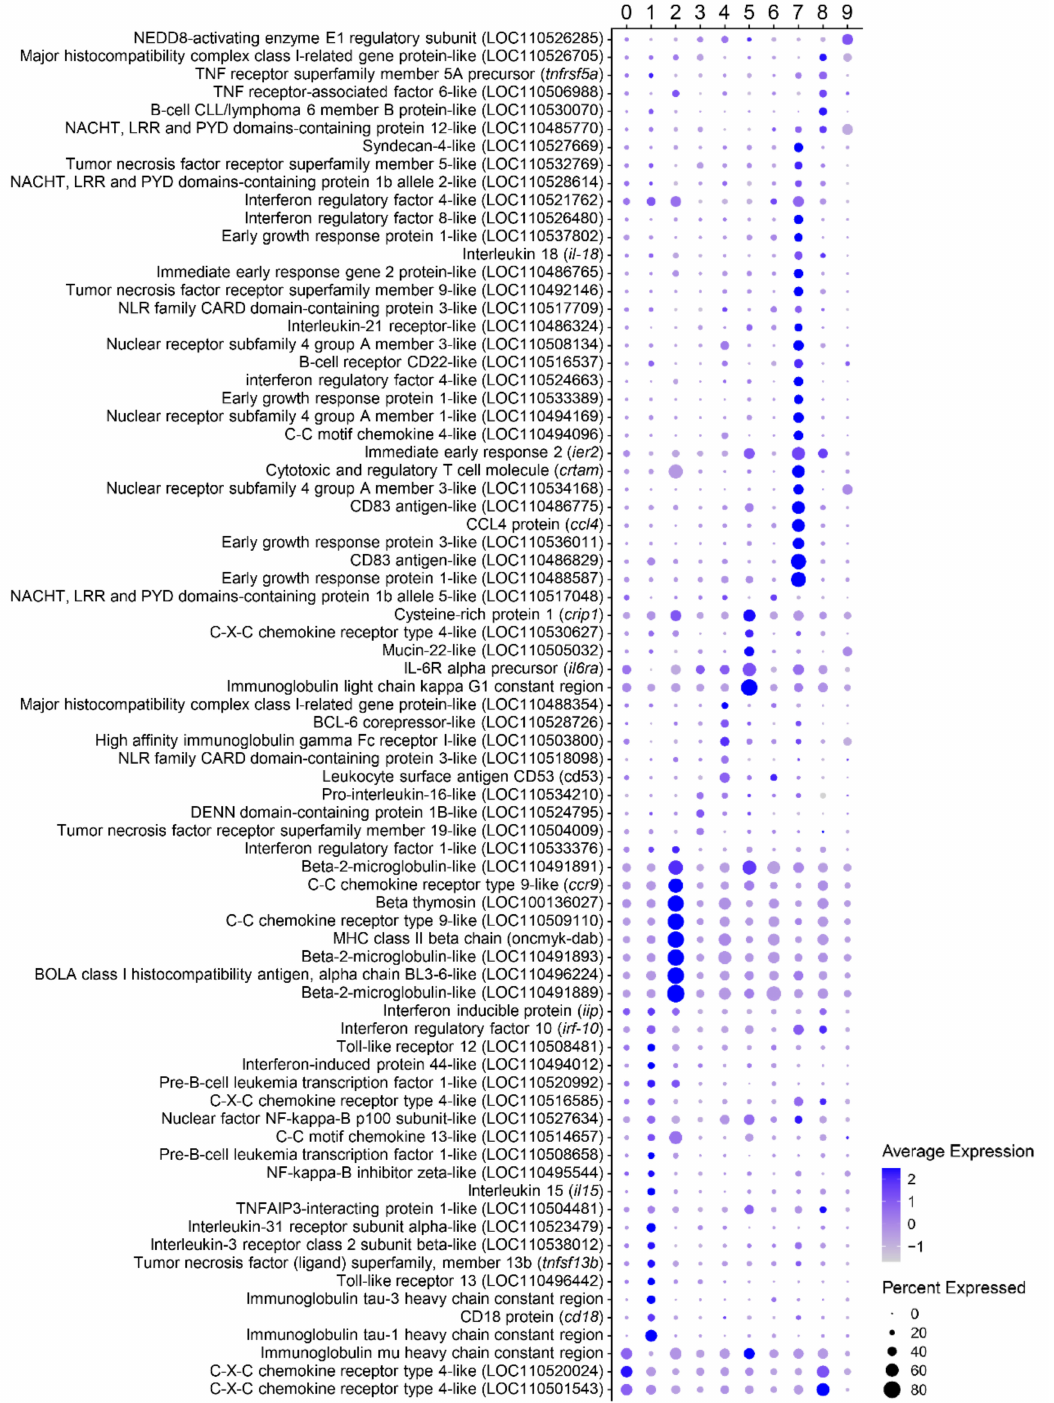
Figure 4. Dot plot analysis showing the marker transcripts identified for each cell cluster related with immune function. For each gene, the average normalized expression (dot color) together with the percentage of cells expressing the gene (dot size) are shown for each